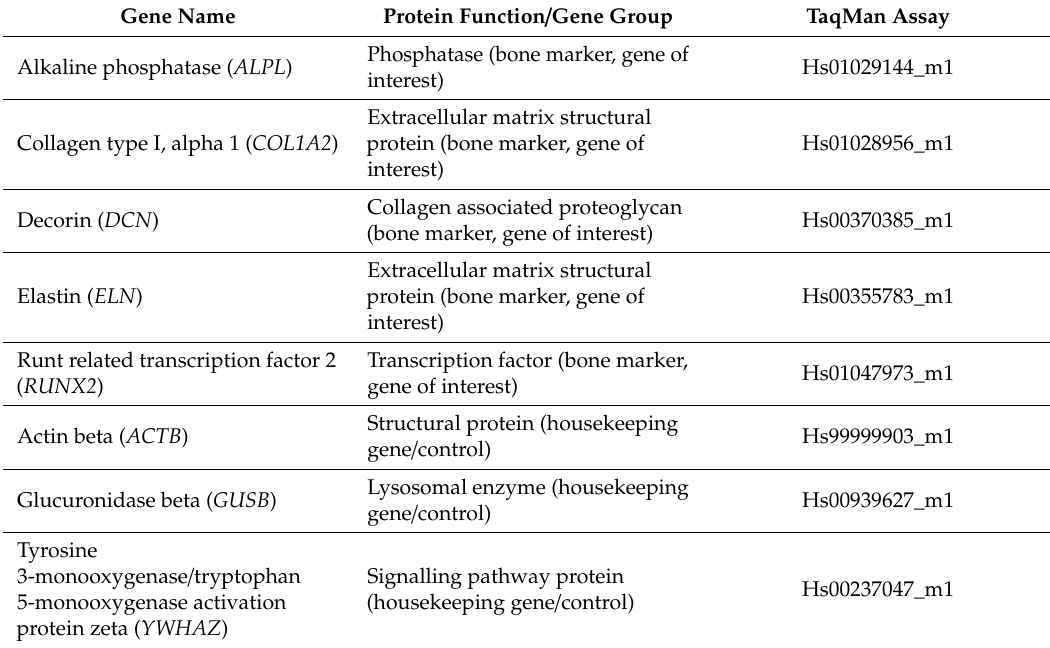
Table 2. TaqMan Real-Time qPCR Gene expression assays